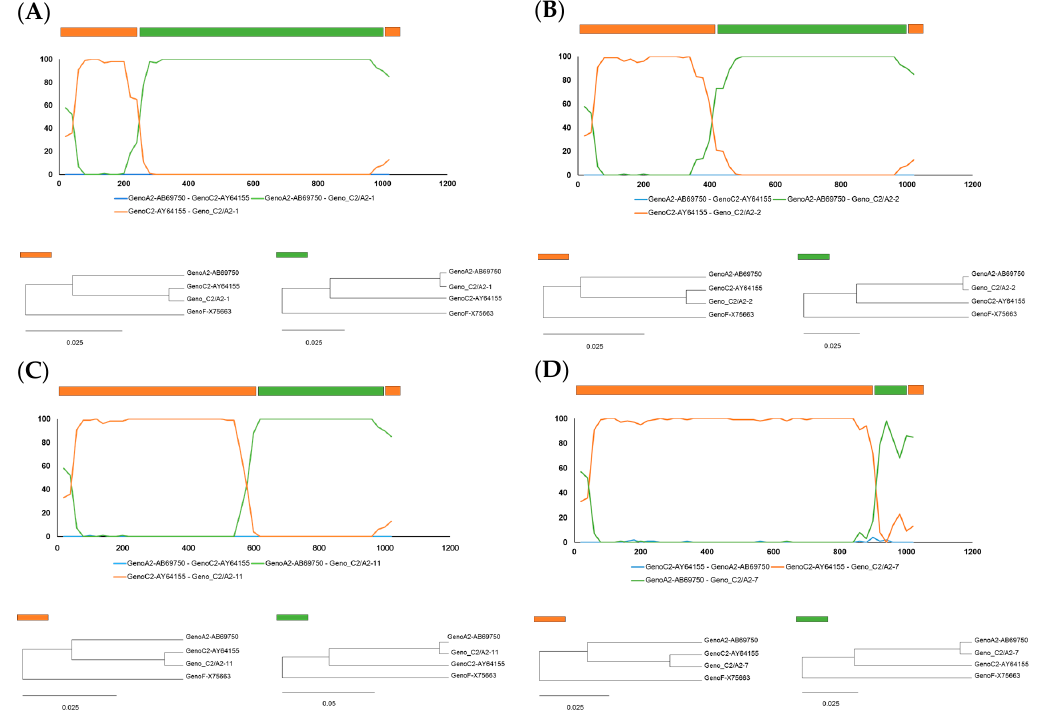
Figure 2. Recombination detection program (RDP) analysis and phylogenetic relationship of four recombinants, ( A ) KKB63-1; ( B ) KKB63-2; ( C ) KKB63-11; and ( D ) KKB63-7. The possible